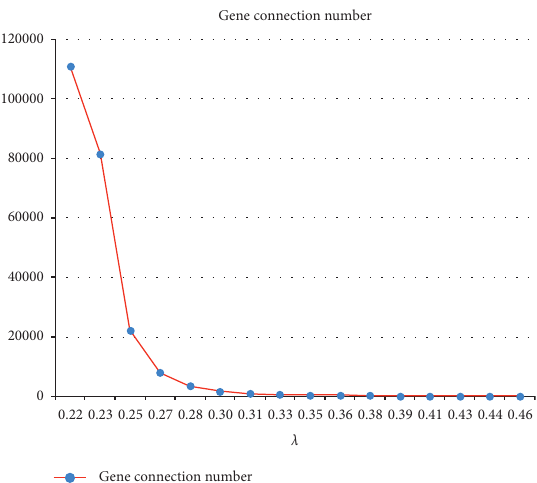
Figure 10: Effect diagram of gene connection number change after threshold λ is increased. Table 1: TOP gene and PR values with different thresholds under the PageRank algorithm. λ � 0.2186(TOP10)